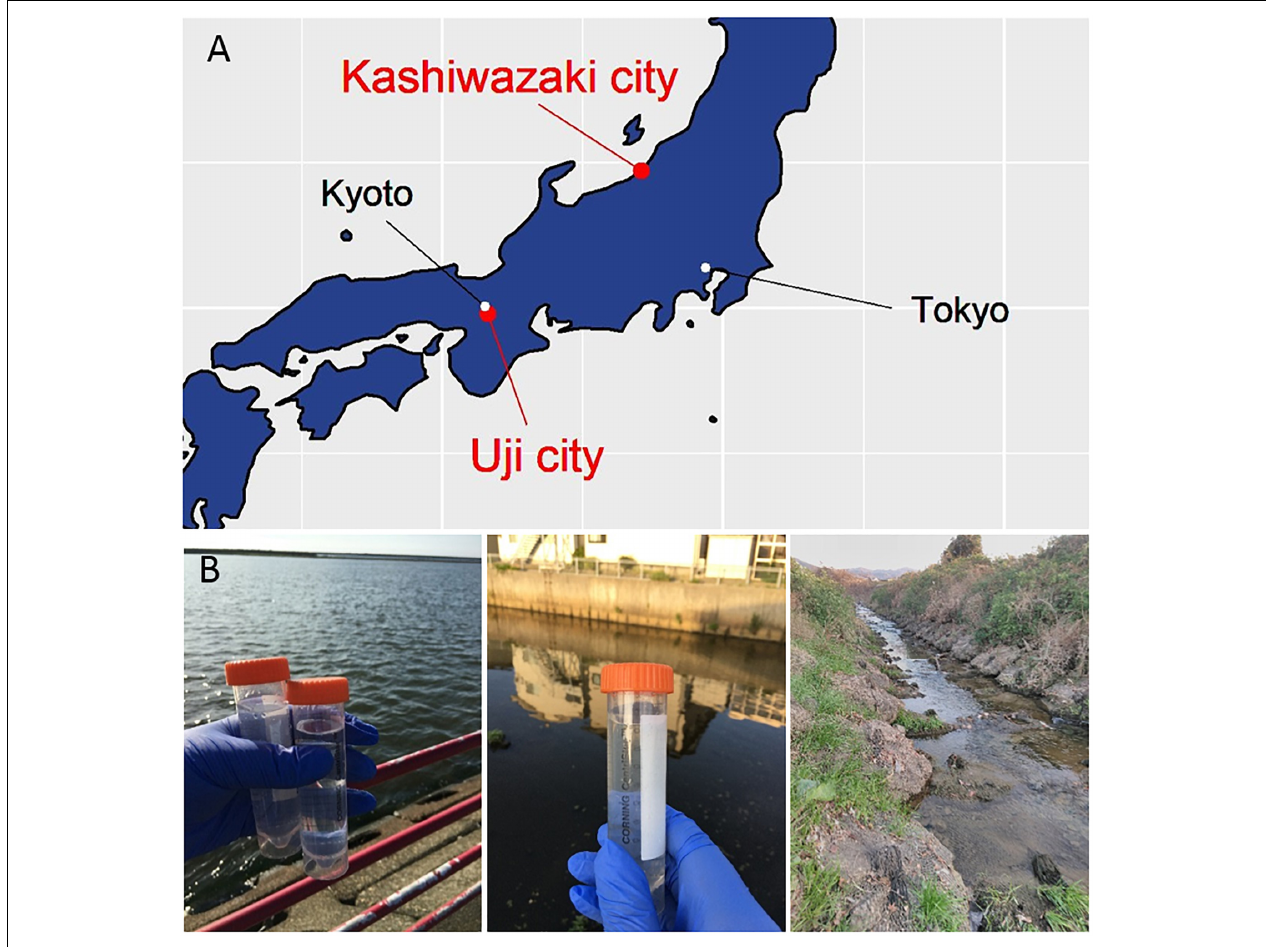
FIGURE 1 | Three sampling locations. (A) Locations of sampling sites in Japanese island. The Ukawa River and Hokuto Town locate in Kashiwazaki City, and the Tatakaigawa locates in Uji City. (B) Photographs of the mouth of the Ukawa River (left panel), a small reservoir near Hokuto Town (middle panel) in Kashiwazaki City, and of the Tatakaigawa River in Uji City (right